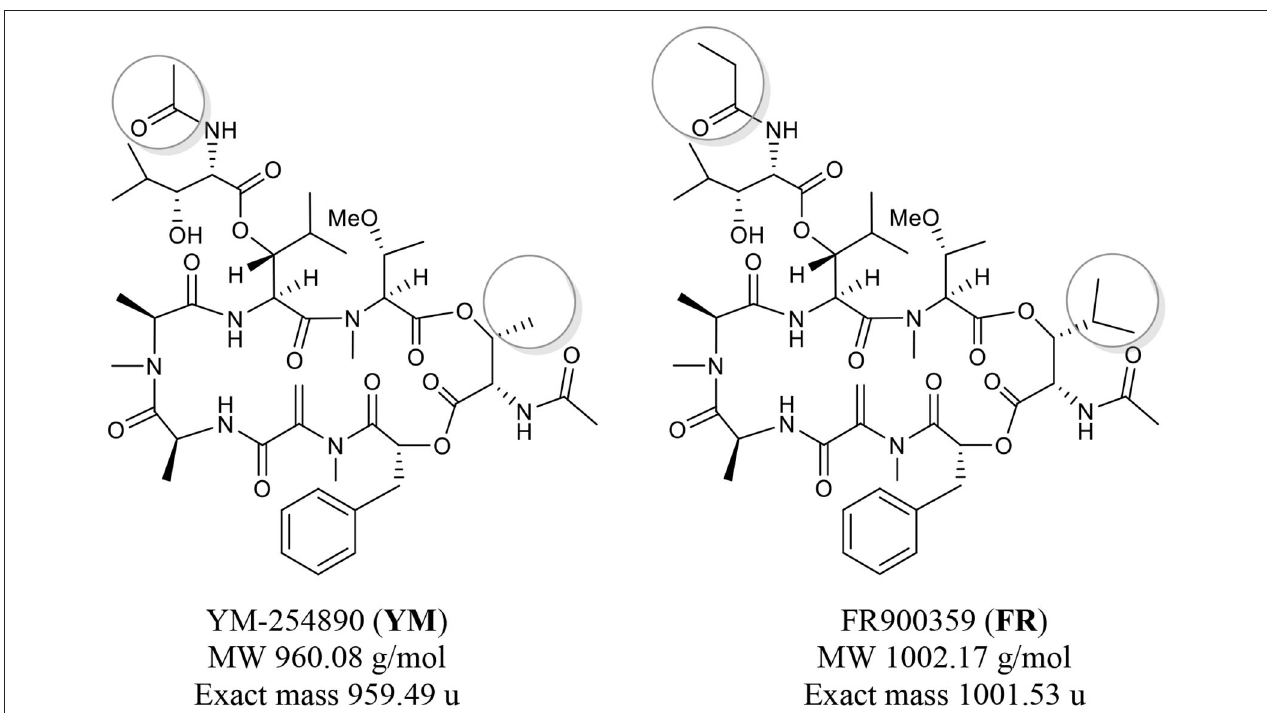
FIGURE 1 | Chemical structures of the macrocyclic depsipeptides YM-254890 (left) and FR900359 (right).